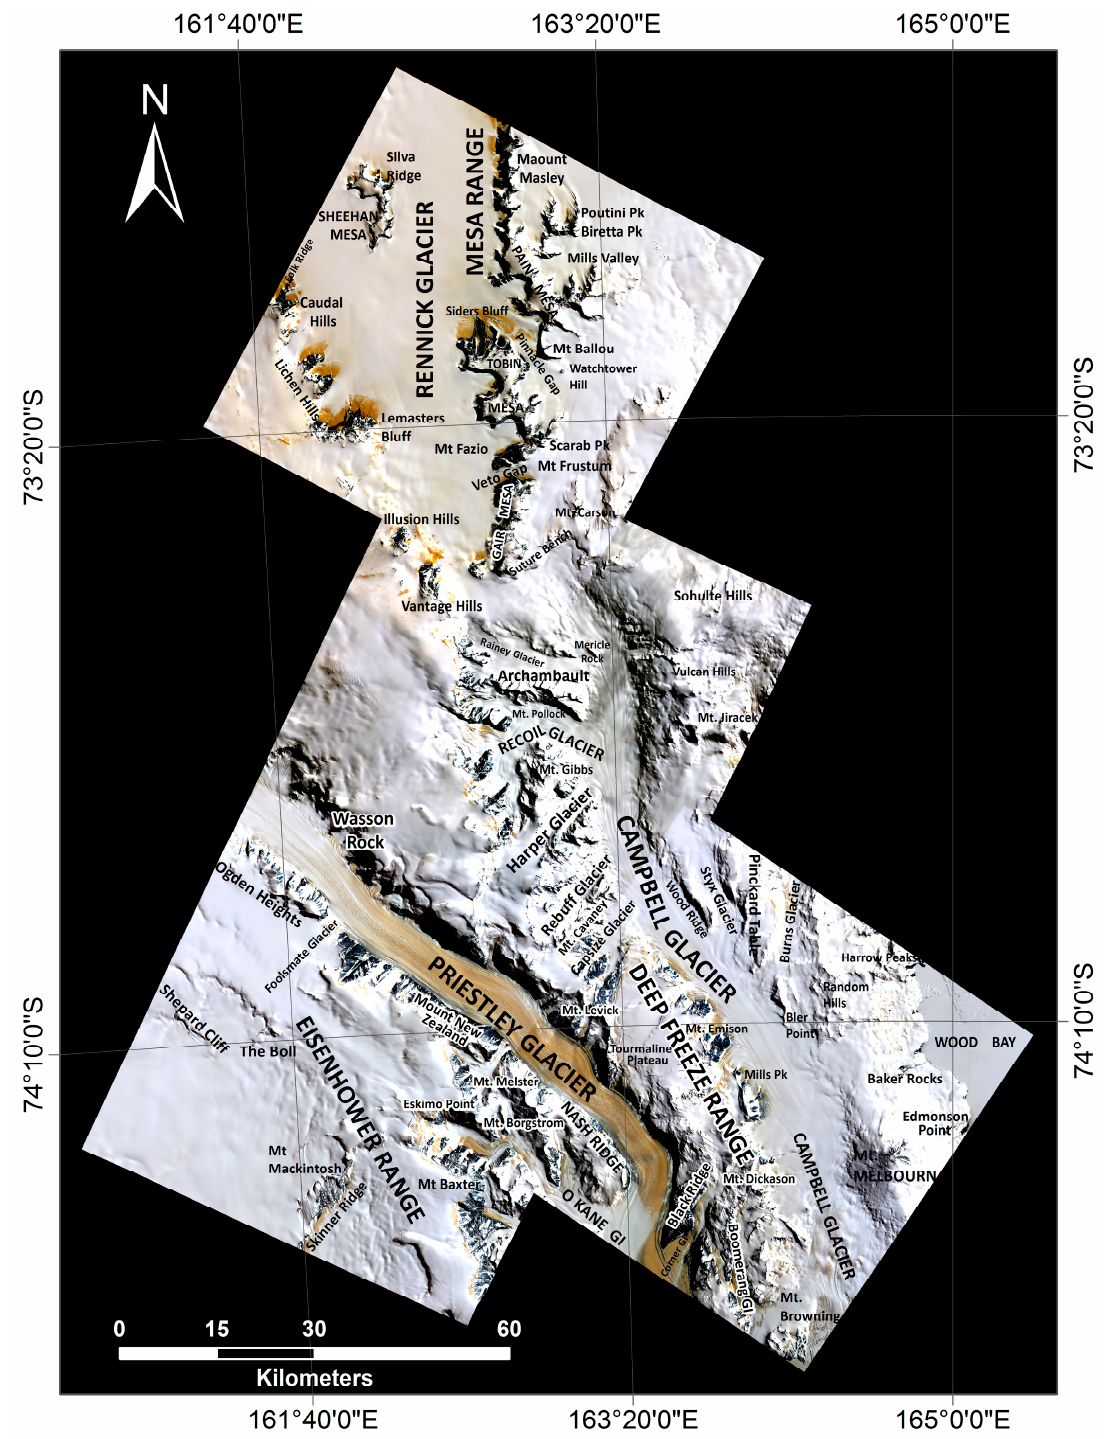
FIG 2 Figure 2. ASTER mosaic of the Mesa Range, Campbell and Priestley Glaciers derived from bands 1, 2 and 3 VNIR as RGB color